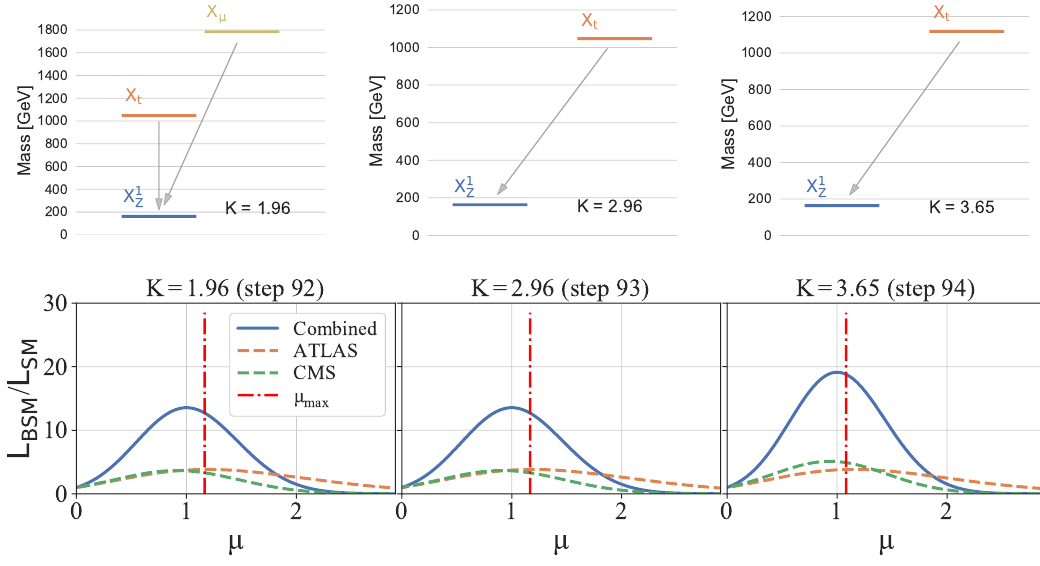
Figure 5 . Examples of the likelihoods as a function of the signal strength µ at three steps for the toy walk discussed in the text. The blue solid curves represent the combined likelihood, while the dashed lines show the individual likelihoods for the ATLAS-SUSY-2016-16 and CMS-SUS-16-050 analyses. The upper limit on µ obtained from the CMS-SUS-19-006 analysis is shown by the dash- dotted red lines. The curves are normalized by the corresponding SM value (at µ = 0 ). The upper panels display the corresponding proto-model particle content and their